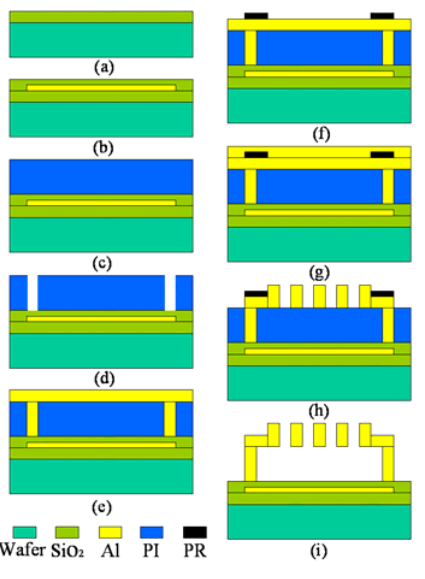
Figure 5. The fabrication process of